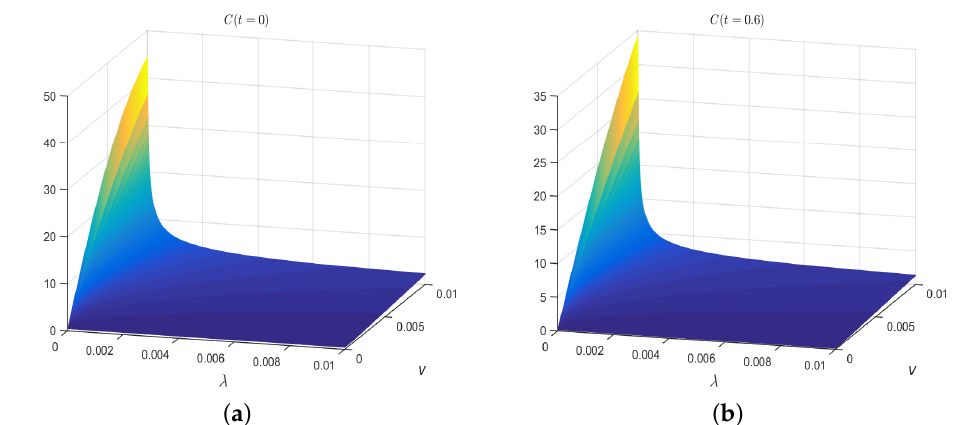
Figure 2. Time evolution of European call option price C ( t ) as a function of v and λ for t = 0 ( a ) and t = 0.6 ( b ).